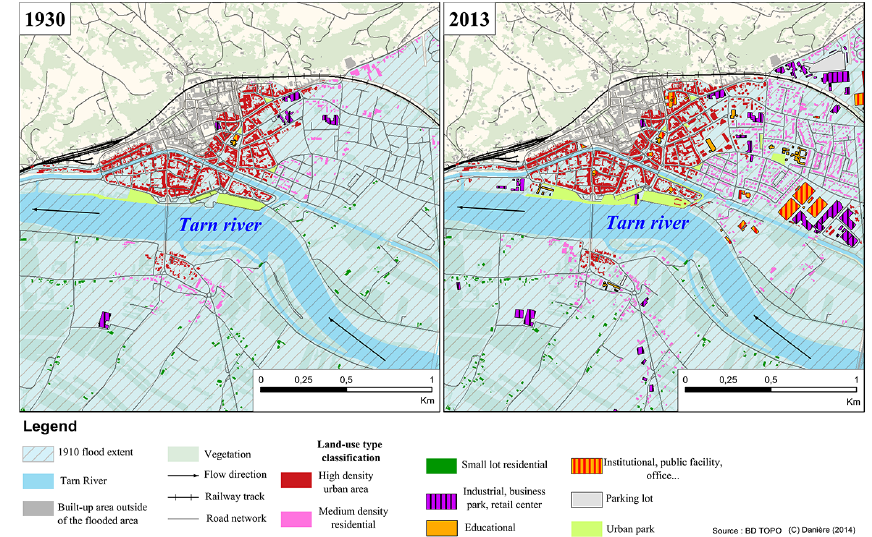
Figure 10. Land-use types and soil occupation within the area affected by the 1930 flood in Moissac: (a) in 1930 and (b) in 2013.